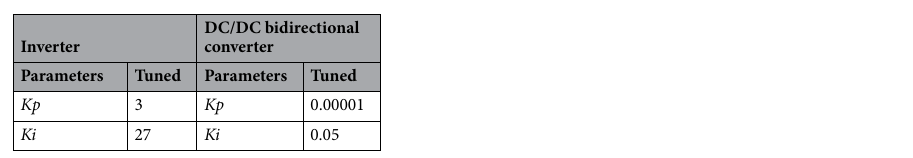
Table 2. The PI controller parameters for inverter and DC/DC bidirectional converter.